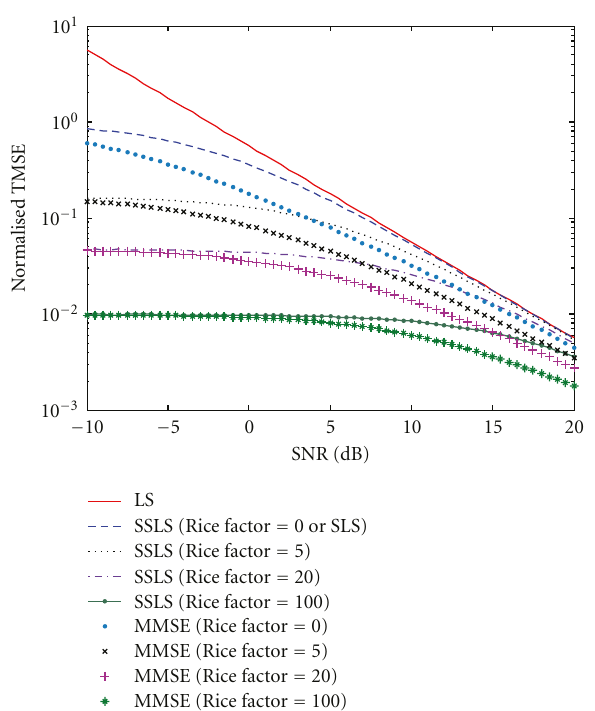
Figure 7: Normalized TMSEs of LS-based and MMSE estimators for various Rice factors in the case of L = 8, N T = N R = 4, N P = 72 .